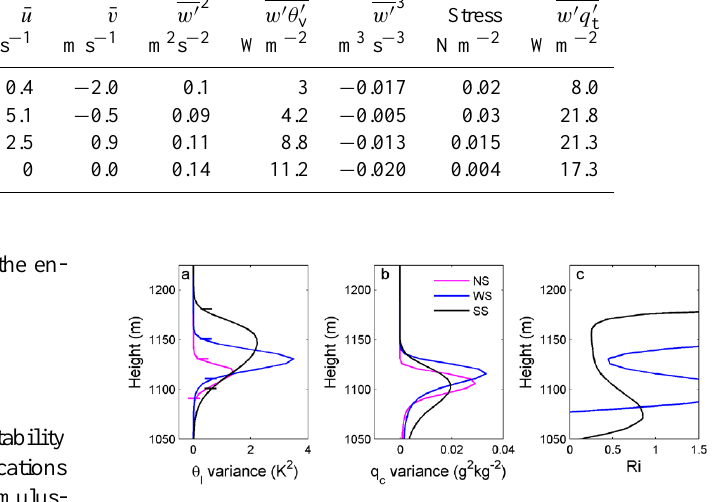
Fig. 5: Profiles of scalar variances and the gradient Richardson number within the inversion. (a) θ 0 2 ; (b) 𝒒 c ; and (c) Ri (its values from NS are ill-defined, and therefore not presented here). The horizontal bars in (a) denote the levels of z itop and z ibase for each simulation. See text for the definition of these